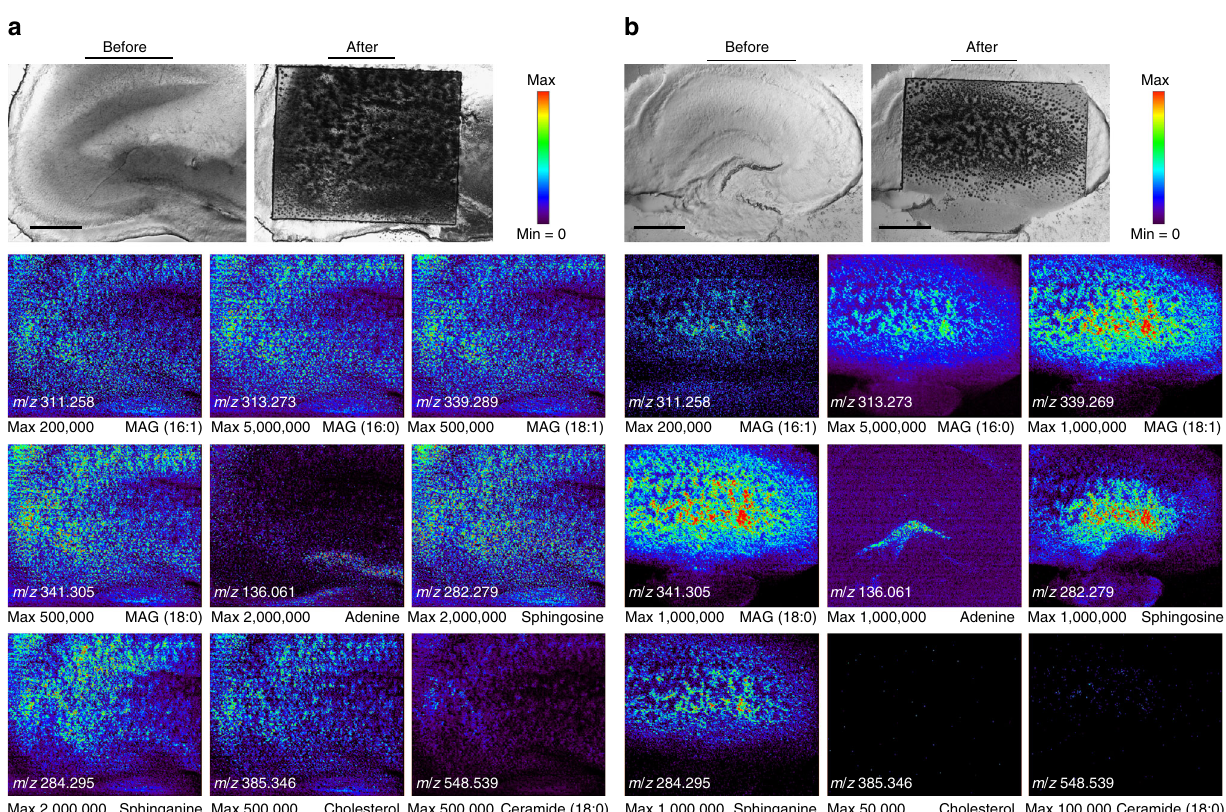
Fig. 7 Ion images obtained for investigation of drug in fl uence. a Normal hippocampal tissue and b a methyl β -cyclodextrin (m β CD)-treated hippocampal tissue of an adult mouse. All experimental and MS analytic conditions were the same as those in Fig. 3. Because the ions of MAG (18:2) shown in Figs. 3 and 4 have relatively low signal intensity as well as similar spatial distribution of other MAG ions, the ion image of MAG (18:2) at m / z = 337.273 was not shown here for nine image layouts in a square shape. Scale bars, 500 μ